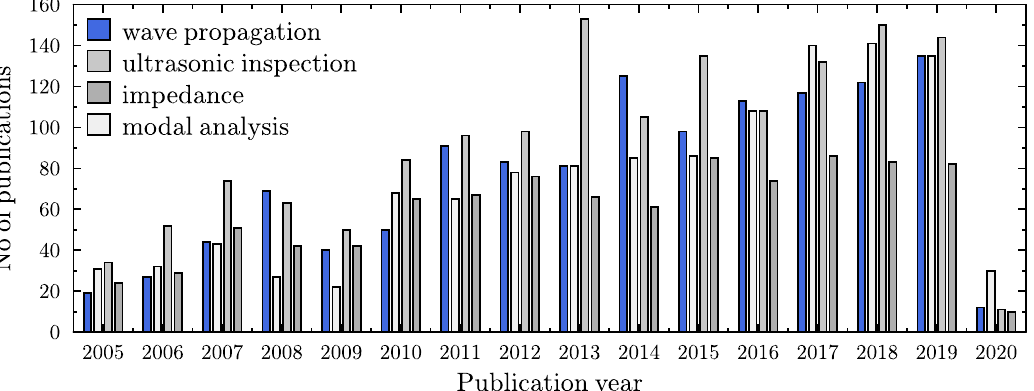
Figure 1. Graphic summary of the number of publications, related with structural parameters used for structural health monitoring (SHM) systems. Web of Science (26 March 2020).